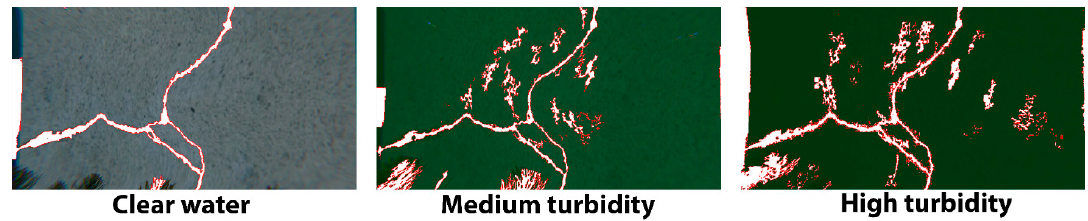
Figure 14. Detected cracks (white pixels) under each turbidity level.